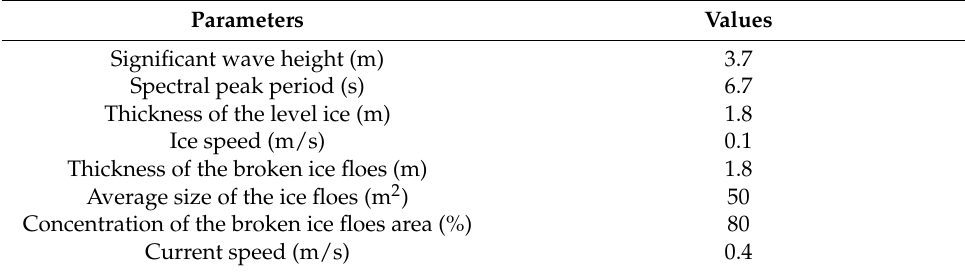
Figure 2. Schematic of the Kulluk platform. ( a ) Numerical model; ( b ) Platform design parameter Figure 2. SchematicoftheKullukplatform. ( a )Numericalmodel;( b )Platformdesignparameterinformation. information. Table 1. The environmental conditions in this